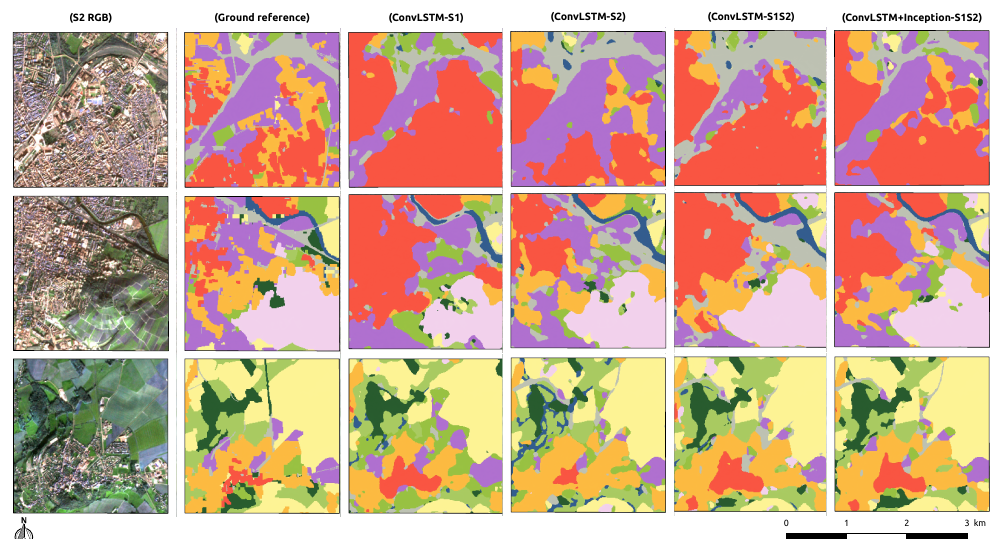
Figure 9. Results for each method for 6 semantic classes (Legend is available in Table 3).